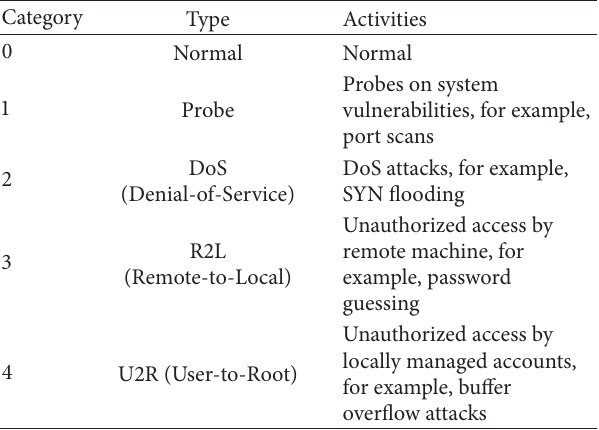
Table 1: Types of